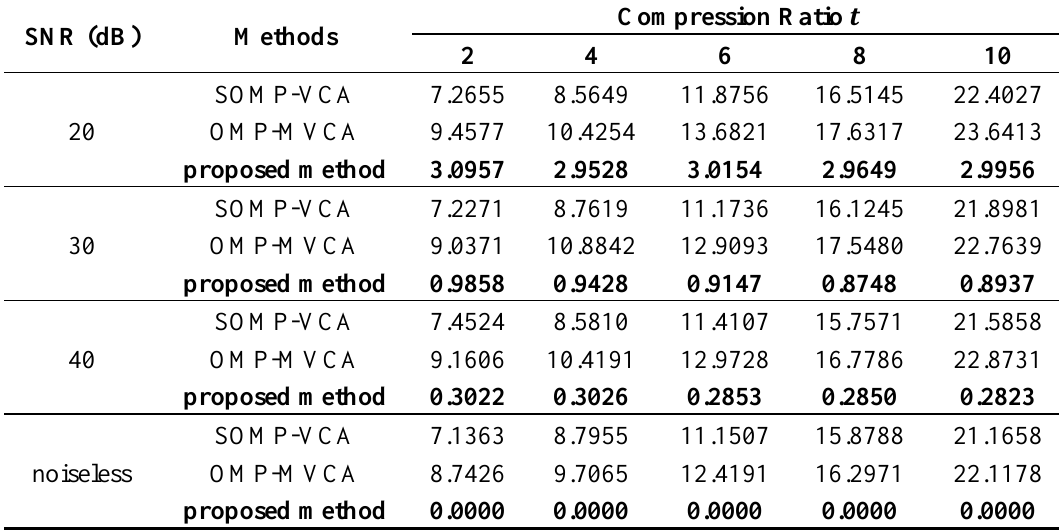
Table 2. Rural HSI: the rmsSAE of the proposed method, SOMP-VCA method and OMP-MVCA method under different noise levels.